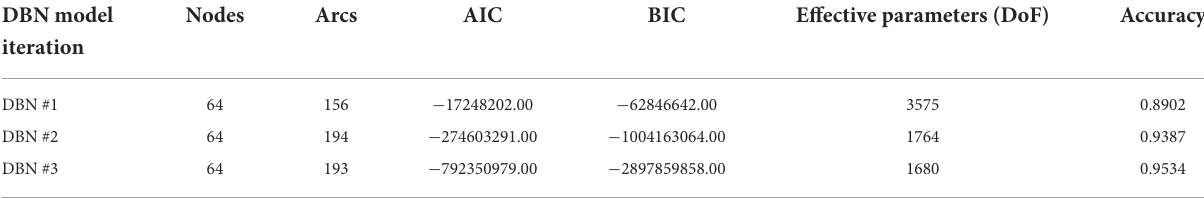
TABLE 4 Diagnostic measurements of the developed predictive